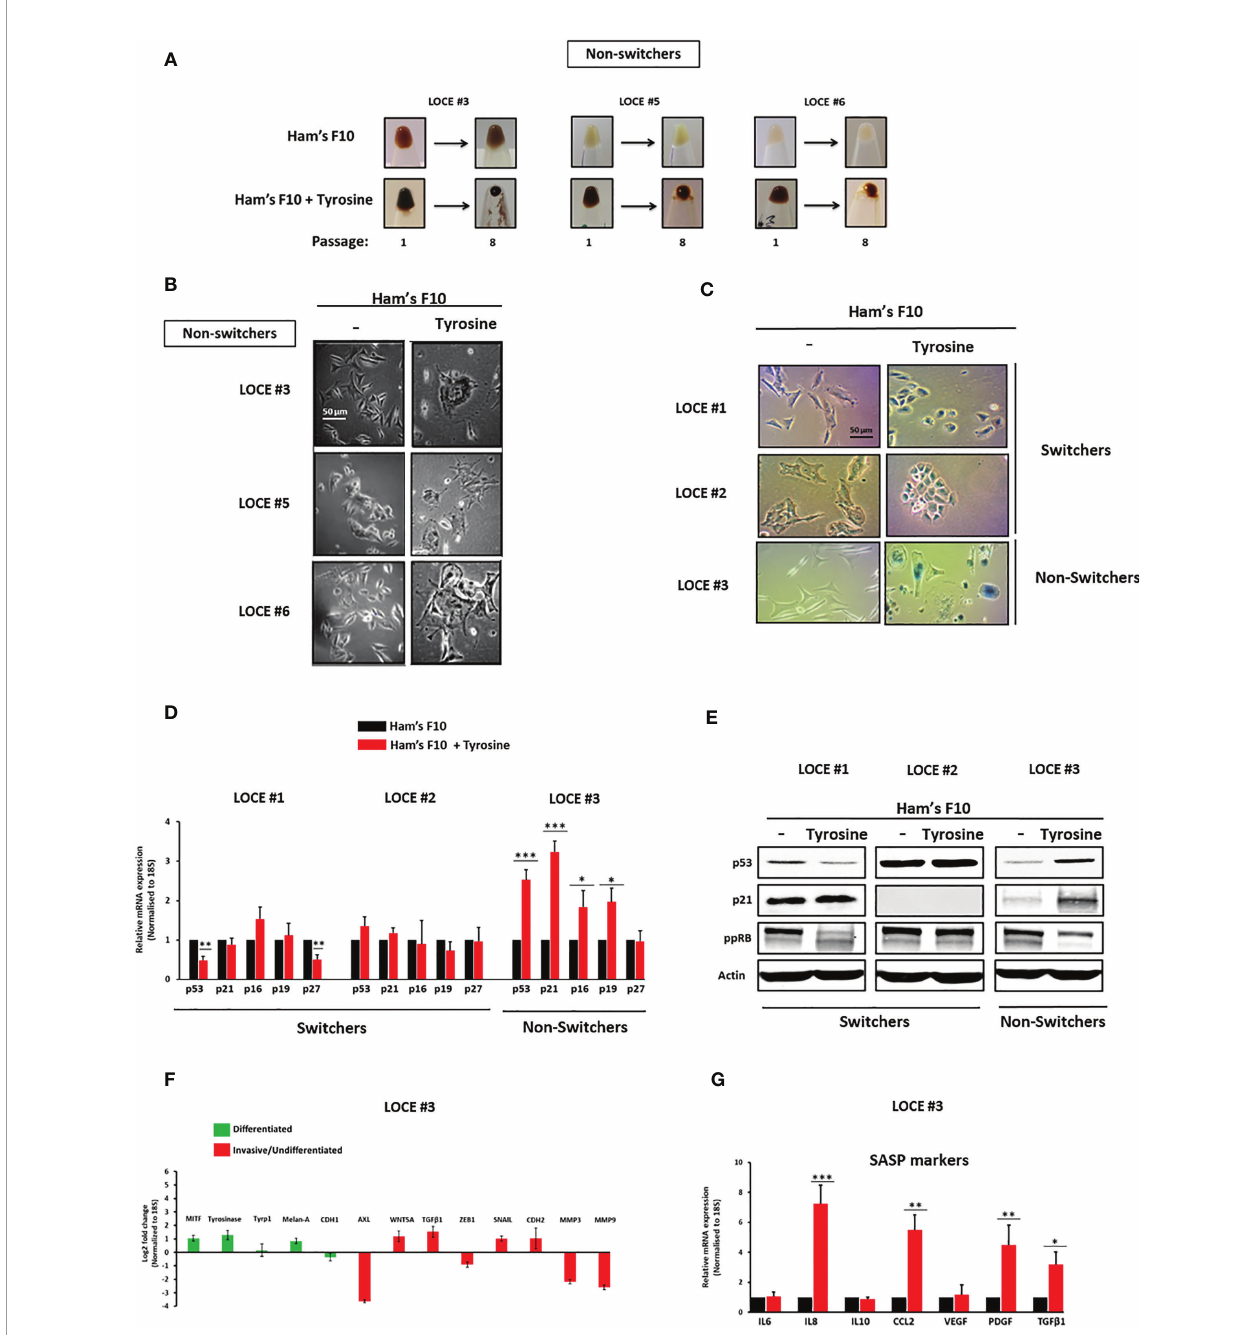
FIGURE 3 | Tyrosine promotes a senescence-like phenotype. (A) Comparison of visible pigmentation of cell pellets from three primary cultures (LOCE #3, 5, and 6) (group of non-switchers) in low tyrosine medium (Ham ’ s F10, 10 µM) and high tyrosine medium (Ham ’ s F10, 100 µM) at passage 1 and 8. (B) Comparison of cell morphology within the non-switchers group in the two culture media (Ham ’ s F10 and Ham ’ s F10 supplemented with tyrosine) (passage 8). (C) , Comparison of b -Gal activity by in situ staining between the primary melanoma cultures (LOCE #1 and 2) (switchers) and the non-switcher primary culture (LOCE #3) in the two culture media (Ham ’ s F10 and Ham ’ s F10 supplemented with tyrosine) (passage 8). (D) Relative mRNA expression (p53, p21, p16, p27, and p29) and (E) protein expression (p53, p21, and ppRB) (representative western blot) of main markers of cell cycle arrest in switchers (LOCE#1 and 2) and non-switcher (LOCE# 3) primary cultures in the two culture media (Ham ’ s F10 and Ham ’ s F10 supplemented with tyrosine) (passage 8). (F, G) Relative mRNA expression by Real-time quantitative PCR of (F) main differentiated (green), invasive markers (red) (Log2-fold change), and (G) , SASP (senescence-associated secretory phenotype) markers in non- switcher primary culture (LOCE# 3) (passage 8) (Fold change was calculated based on gene expression in Ham ’ s F10 supplemented with tyrosine relative to Ham ’ s F10). Data are presented as means ± SEM from three independent experiments (*p < 0.05; **p < 0.01; ***p < 0.001,